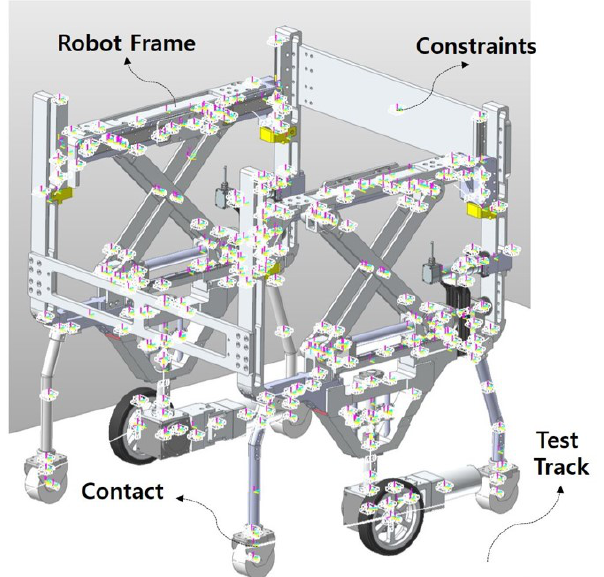
Figure 12. CAE analysis environment based on 3D design for the mobile part of the system. Contact environment friction coefficient = 1 and damping coefficient = 10. The system material set Al60 as the same as the real